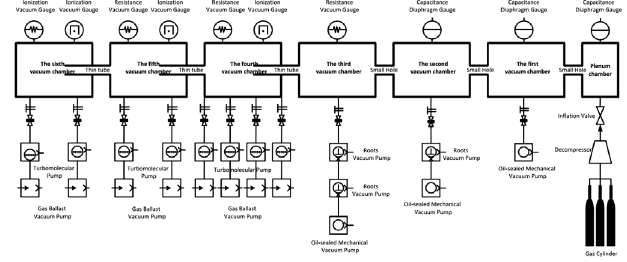
FIG. 18. The sketch of the VDS prototype.